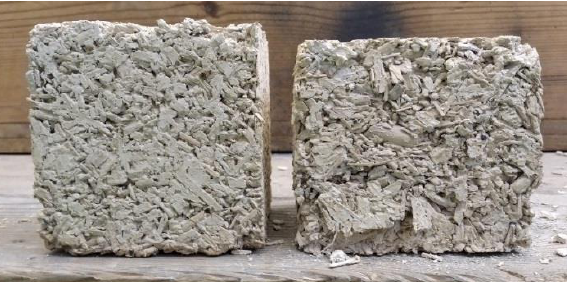
Figure 17. The form of destruction of composite specimen: Original sample (left), damaged sample — 15% deformation (right).